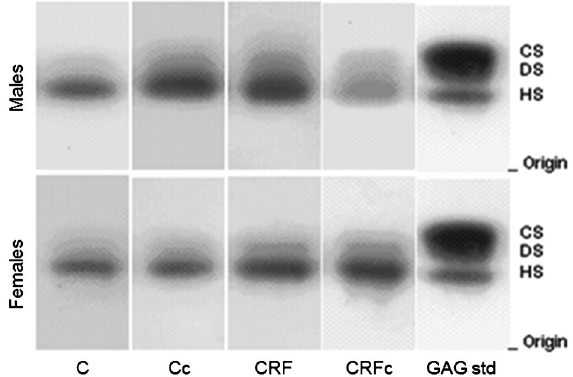
Figure 3. Agarose gel electrophoresis of total renal glycosami- noglycans (rGAGs) after toluidine blue staining. CS: chondroitin sulfate; DS: dermatan sulfate; HS: heparan sulfate; C: control; c: castration; CRF: chronic renal failure; GAG std: mixture of standard